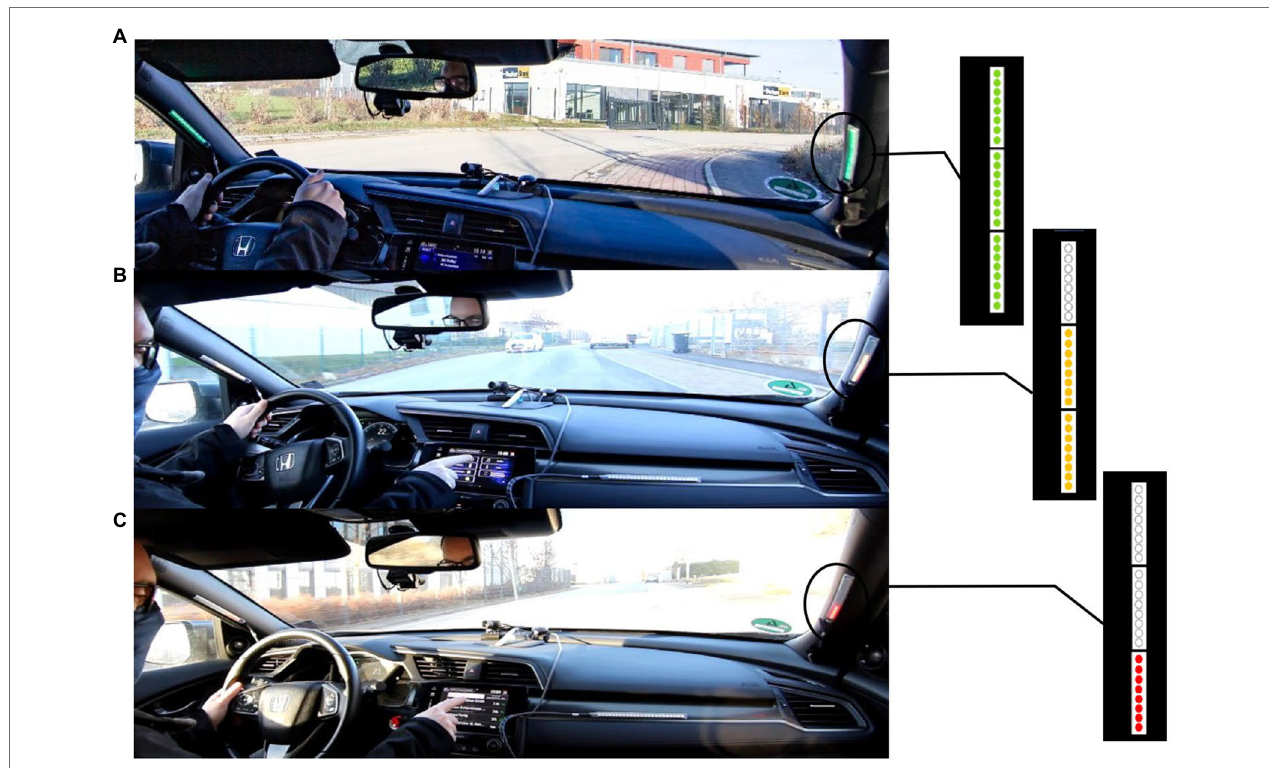
FIGURE 1 | State transition of the LEDs strips communicating (A) high attentiveness, (B) medium, and (C) very low attentiveness as driver is performing a secondary